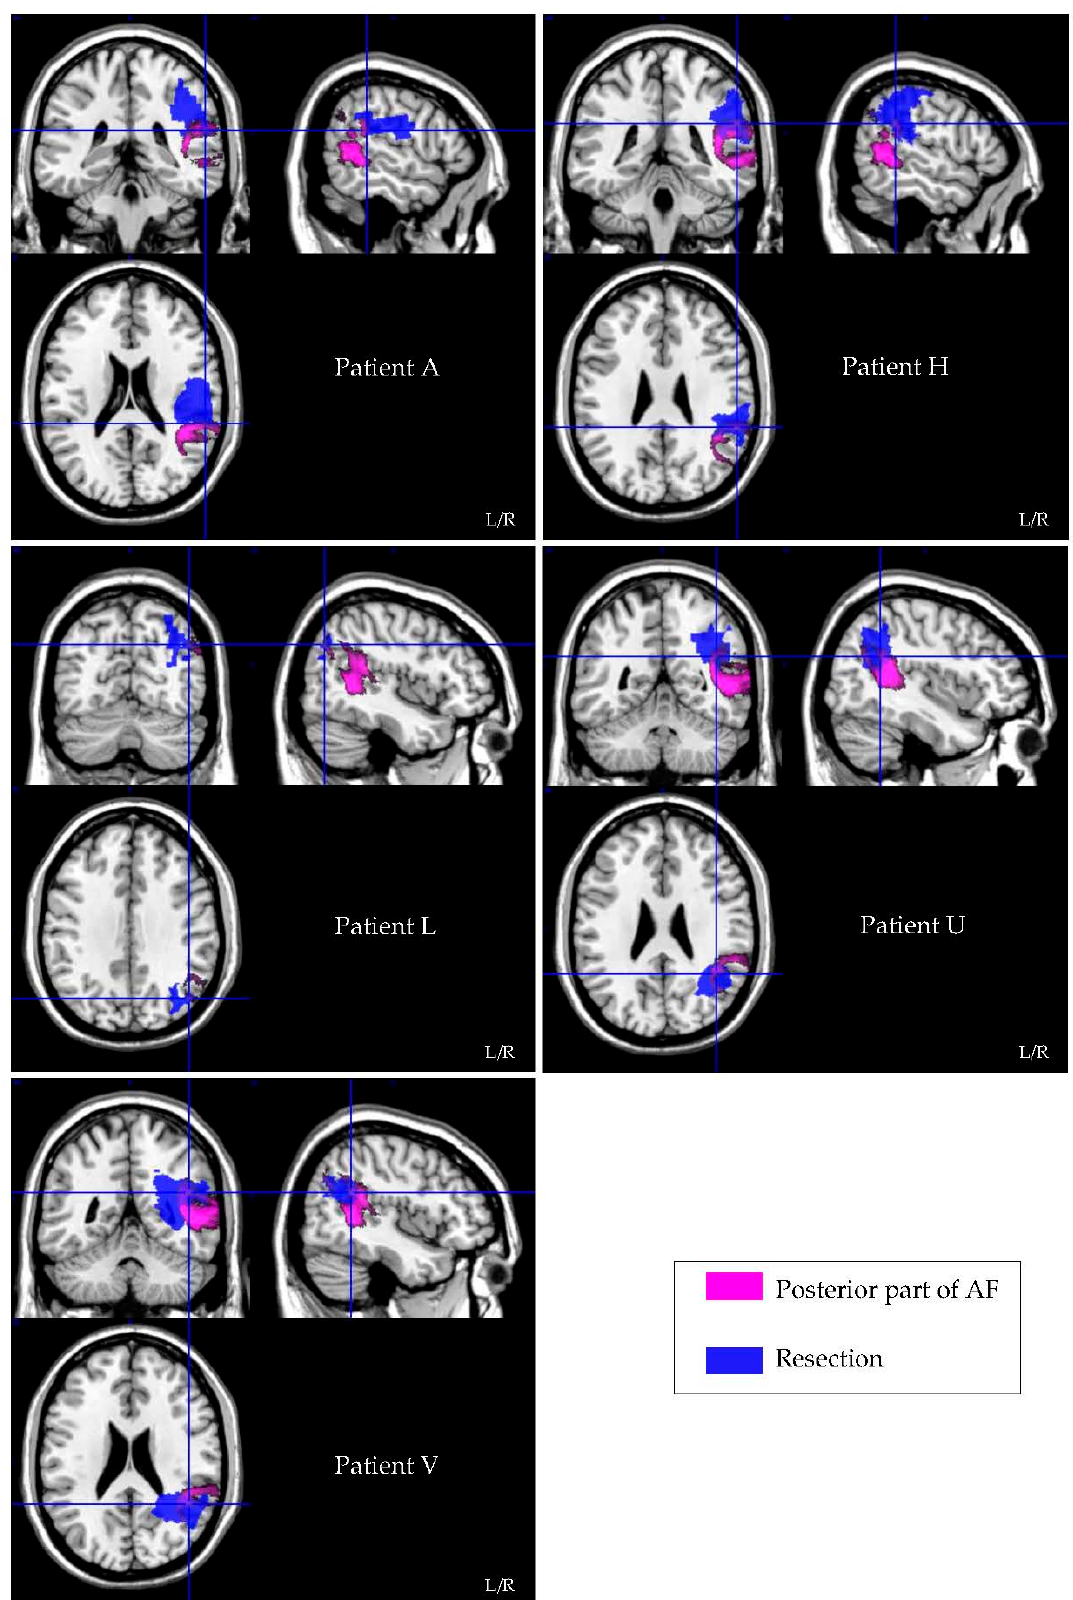
Figure 2. Colour-encoded white matter tract (posterior part of AF = pink) incorporated in individual resection overlays (resection = blue) of patients who declined in TMT B/A performance.